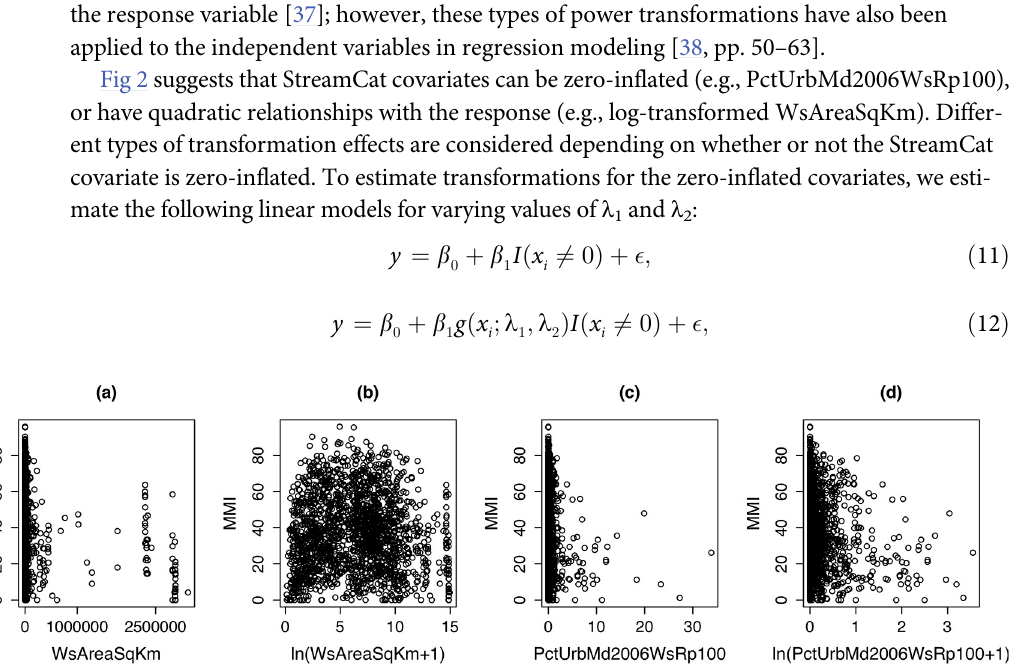
Fig 2. Scatter plots of MMI versus StreamCat covariates. (a) watershed area in square kilometers (WsAreaSqKm); (b) natural logarithm of WsAreaSqKm; (c) percent of watershed area classified as developed, medium intensity land use in 2006 within a 100 meter buffer of a stream reach (PctUrbMd2006WsRp100); (d) natural logarithm of PctUrbMd2006WsRp100.